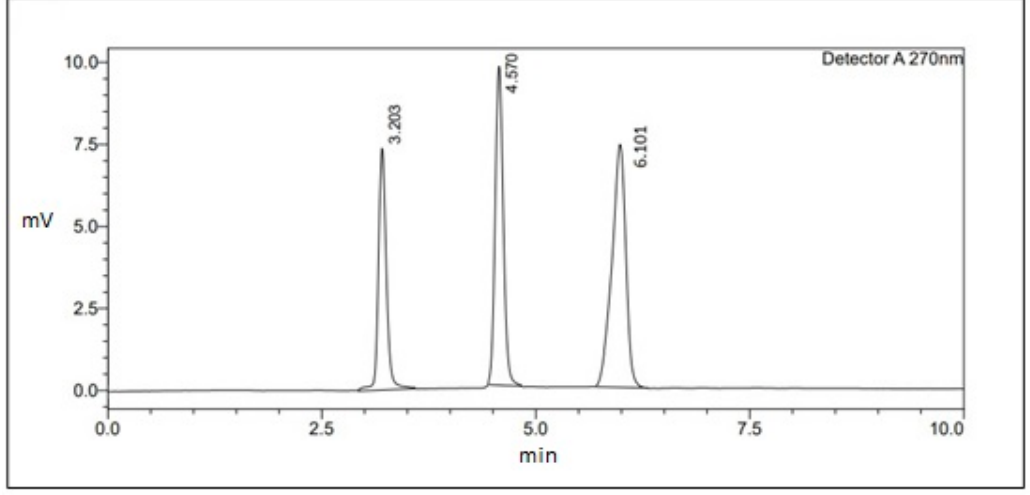
Figure 2. RP-HPLC chromatogram of DOM, CIN and IRB in the mobile phase.